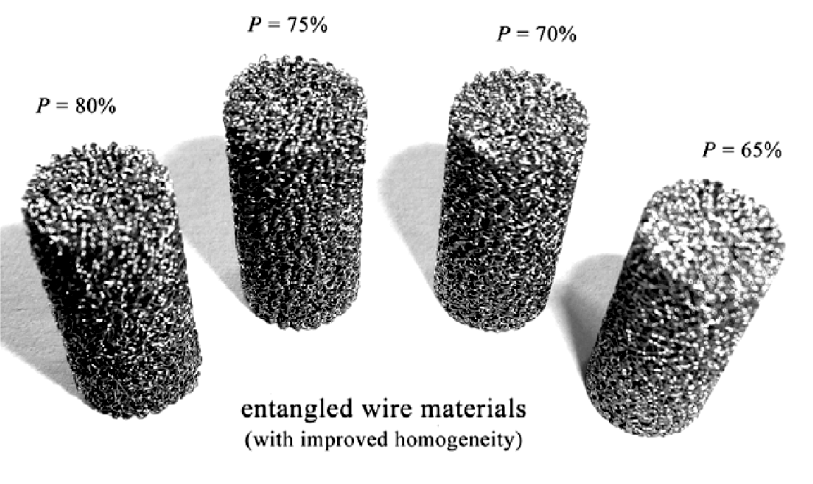
Figure 33. Entangled metallic wire materials with improved homogeneity [57]. Reprinted with permission from [57]. Copyright 2012